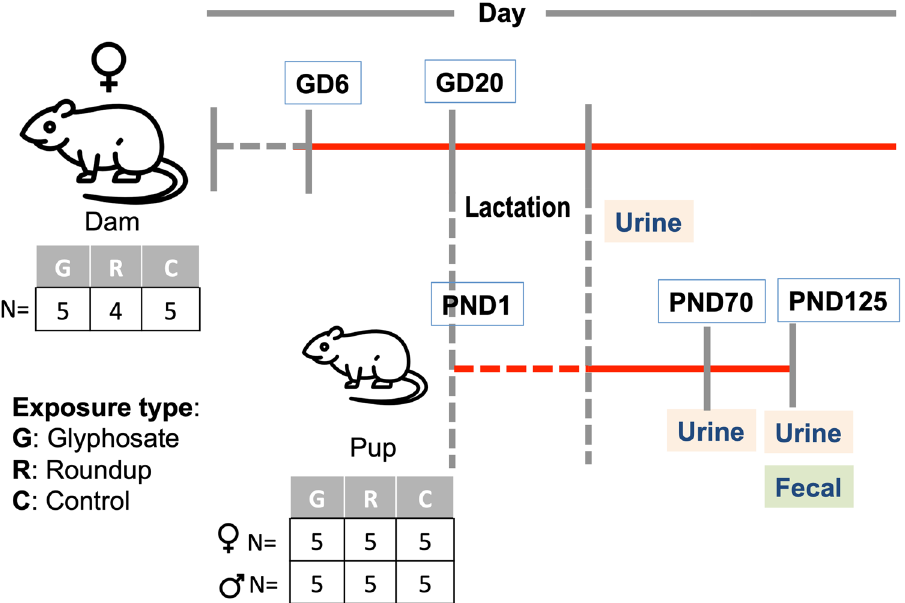
Figure 1. Study design. Test compounds including pure glyphosate and Roundup are administered ad libitum in drinking water. Fourteen dams are treated through drinking water starting from the gestation day 6th (GD 6). Thirty pups are treated from embryonic life (GD 6) indirectly from dams milk following birth (GD20) until the end of lactation, then directly through drinking water for 90 days after weaning (until PND 125). Urine samples are collected after lactation from dams and PND70 and PND 125 from pups. Fecal samples are collected at PND 125 from